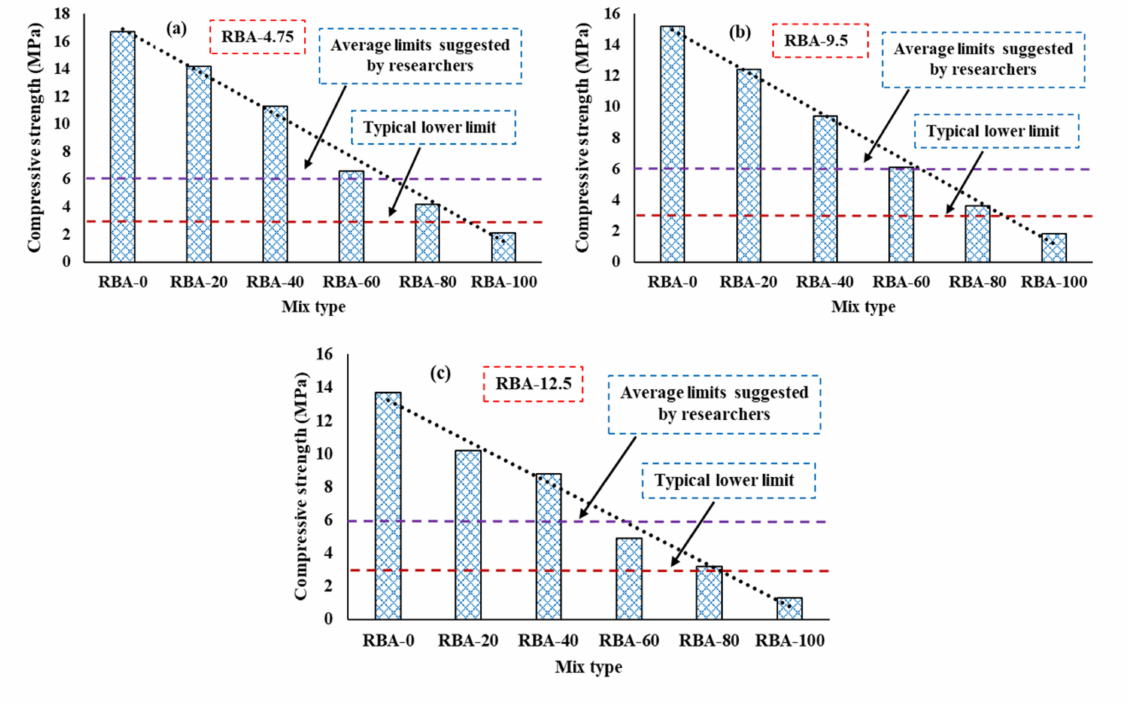
Figure 4. Compressive strength of PC mixes, ( a ) for RBA-4.75, ( b ) RBA-9.5, ( c )